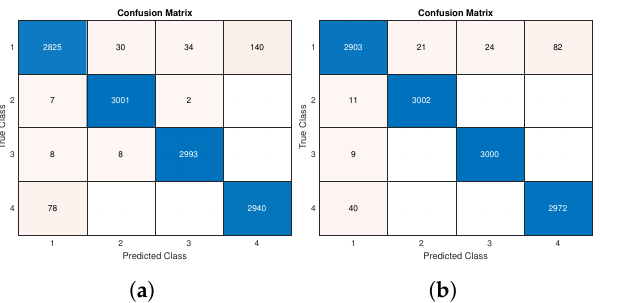
Figure 9. Confusion matrix of test phase: ( a ) considering acceleration data from all axes; ( b ) consider- ing acceleration and angular velocity data from all